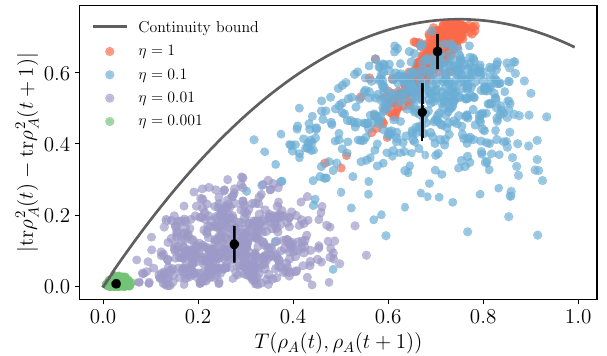
FIG. 4. We numerically illustrate the continuity bound Eq. (7) and its relation to the learning rate η for t = 0, i.e., at the begin- ning of the optimization schedule. This shows that one should be careful with the choice of the learning rate since a large learn- ing rate leads to a big change in the trace distance and change in purity. We use a system size of N = 10 and a random circuit with circuit depth p = 100 and small qubit rotations ( (cid:11) θ = 0.05) to generate a BP-free initialization. Data is averaged over 500 random